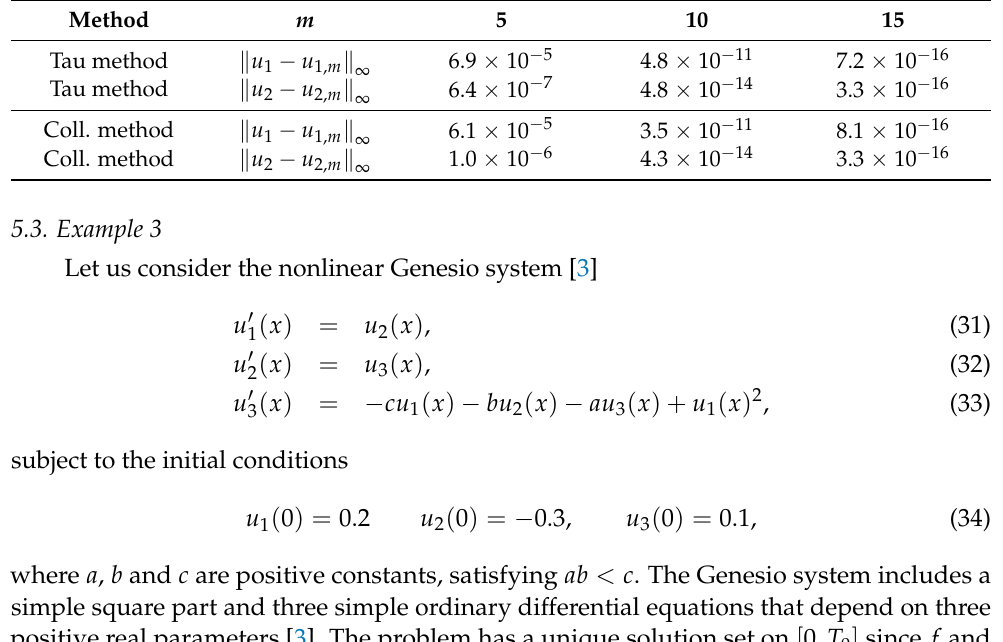
Table 2. The maximum absolute errors on the interval [ 0,1 ] for different values of m and Example 2.